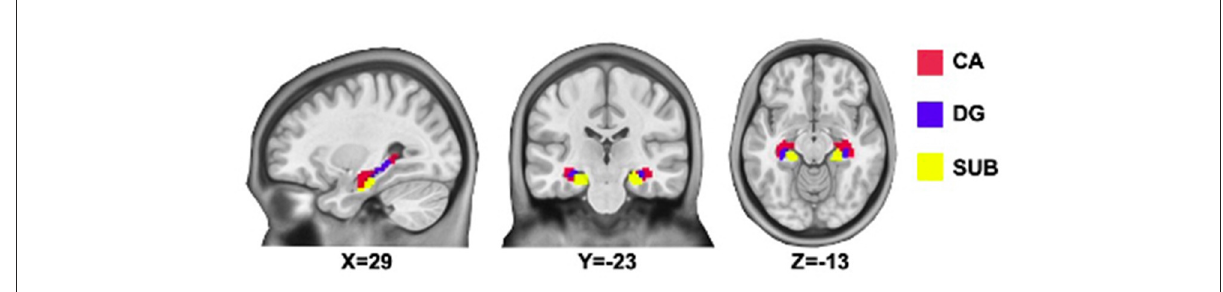
FIGURE1 Hippocampal subregions. CA, Cornu Ammonis (shown in red); DG, Dentate Gyrus (shown in blue); SUB, subiculum (shown in yellow).